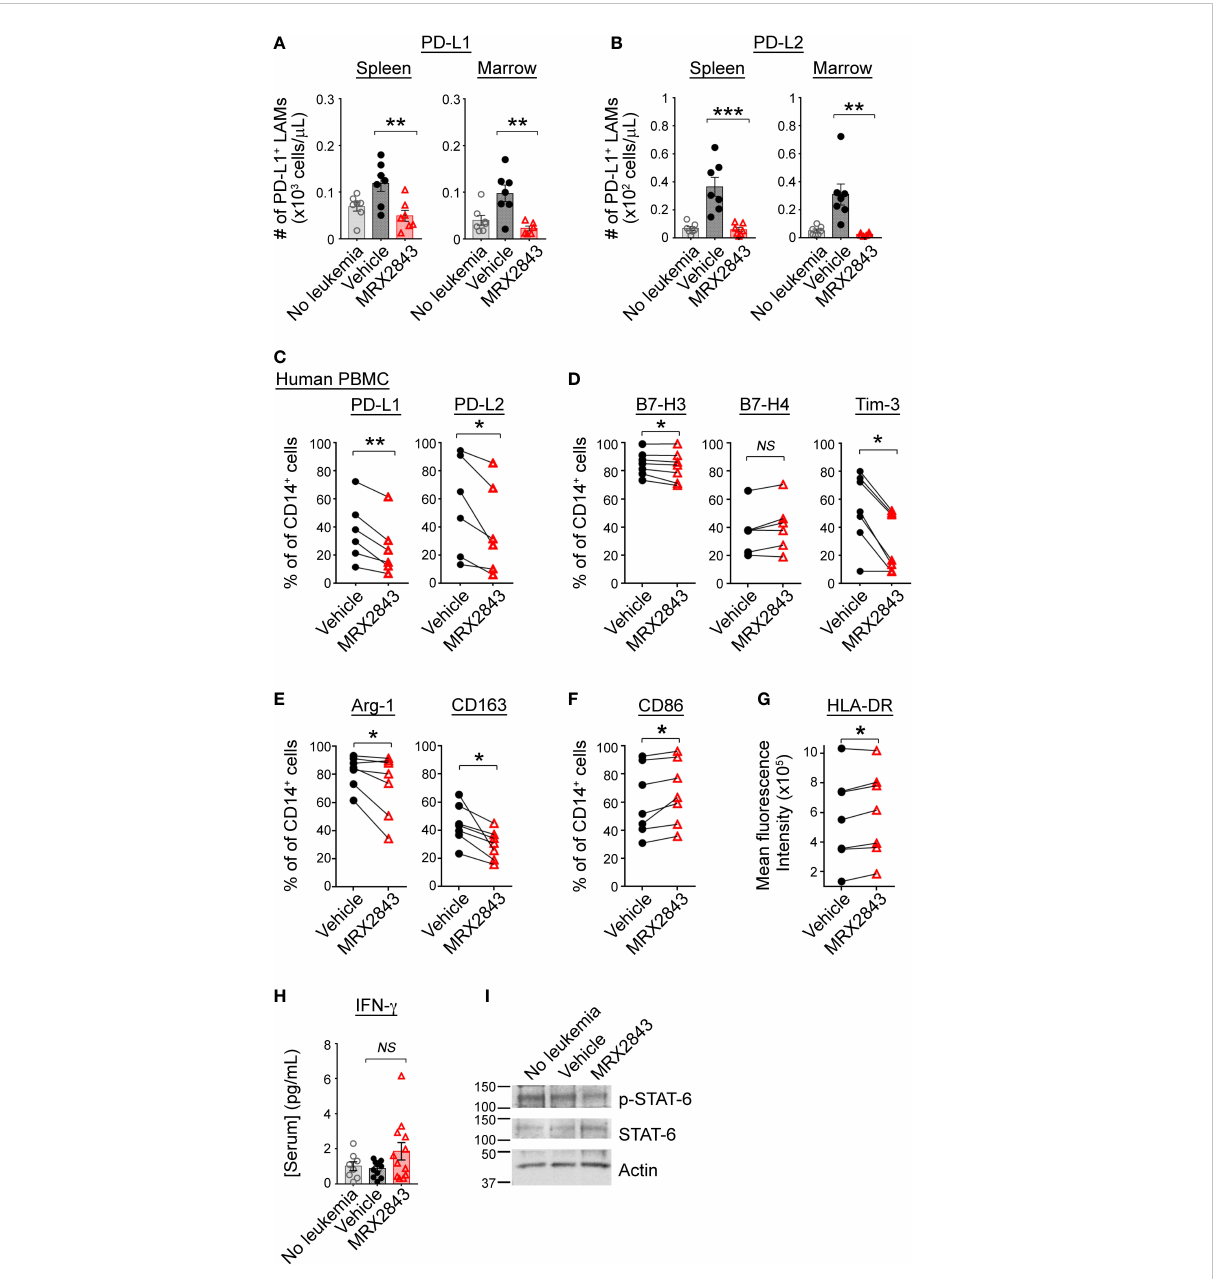
FIGURE 2 MerTK inhibition skews macrophage polarization in the leukemia microenvironment. (A, B) As described in Figure 1G, C57BL/6 mice were inoculated with syngeneic MLL-ENL AML and treated daily with MerTK inhibitor MRX2843 (red triangle) or vehicle (saline; black circle); mice not inoculated with leukemia are shown as controls (gray open circle). Three weeks after inoculation, spleens and marrow were harvested and assessed by fl ow cytometric analysis. (A) Quanti fi cation of PD-L1 expressing LAMs in the spleen and marrow. (B) Quanti fi cation of PD-L2 expressing LAMs in the spleen and marrow. (C – G) Macrophages derived from human peripheral blood mononuclear cells (PBMC) co-cultured with Kasumi-1 AML cells and MRX2843 or vehicle were analyzed by fl ow cytometry. Percentage of cultured macrophages expressing (C) PD-L1 and PD-L2, and (D) B7-H3, B7-H4 and Tim-3, (E) Arginase-1, CD163, and (F) CD86. (G) Flow cytometric quanti fi cation of HLA-DR mean fl uorescence intensity of co-cultured macrophages. (H) Serum from mice described in Figure 1G was subjected to Luminex for interferon-gamma (IFN- g ). (I) Murine bone marrow derived macrophages (BMDMs) were co-cultured with MLL-ENL AML cells and macrophage whole cell lysates were analyzed by immunoblot. Representative immunoblot showing phosphorylated STAT6 (p-STAT6) and total STAT6. Actin was used as a loading control. (A, B, H) were analyzed using 1-way ANOVA. (B – G) were analyzed using student ’ s t-test (*p<0.05, **p<0.01, ***p<0.001, NS, not signi fi